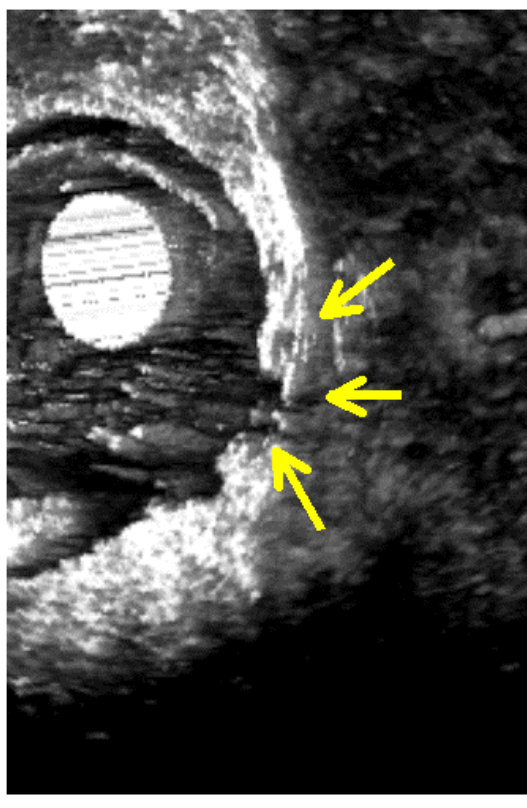
FIGURE 4. Rectal cancer with complete involvement of mesorectum (usT4) (arrows).